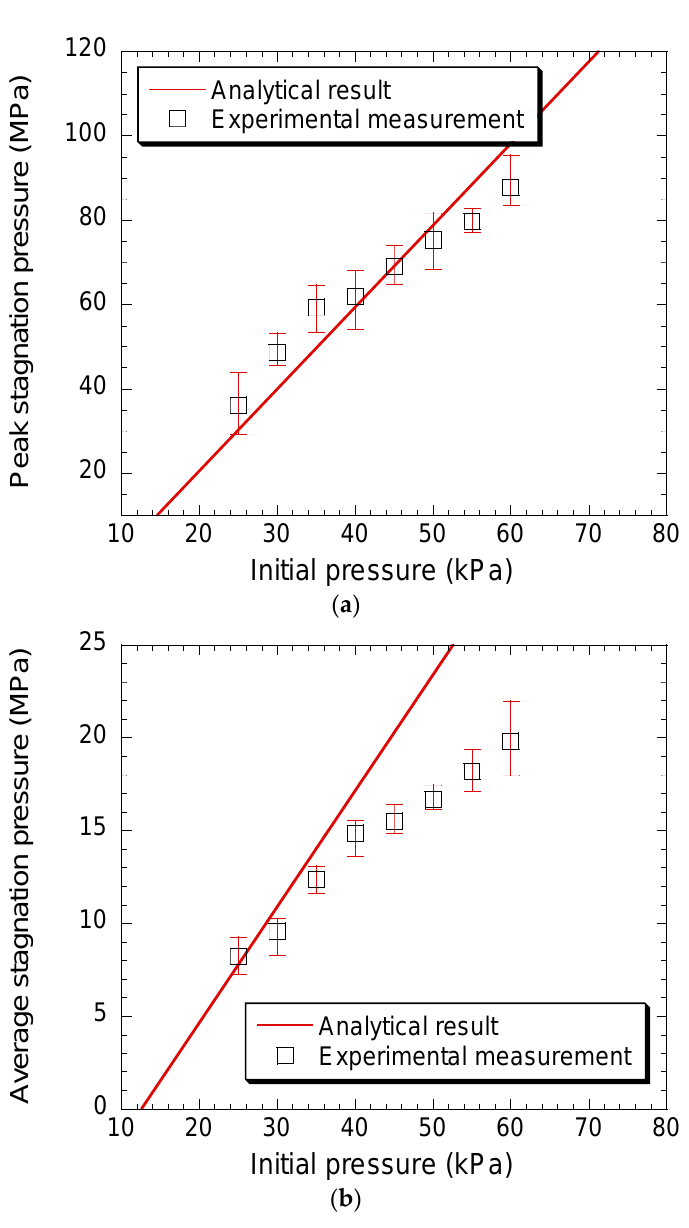
Figure 7. Results of the ( a ) peak pressure; and ( b ) average stagnation pressures as a function of the combustible initial pressure, respectively. The solid lines represent the model results.